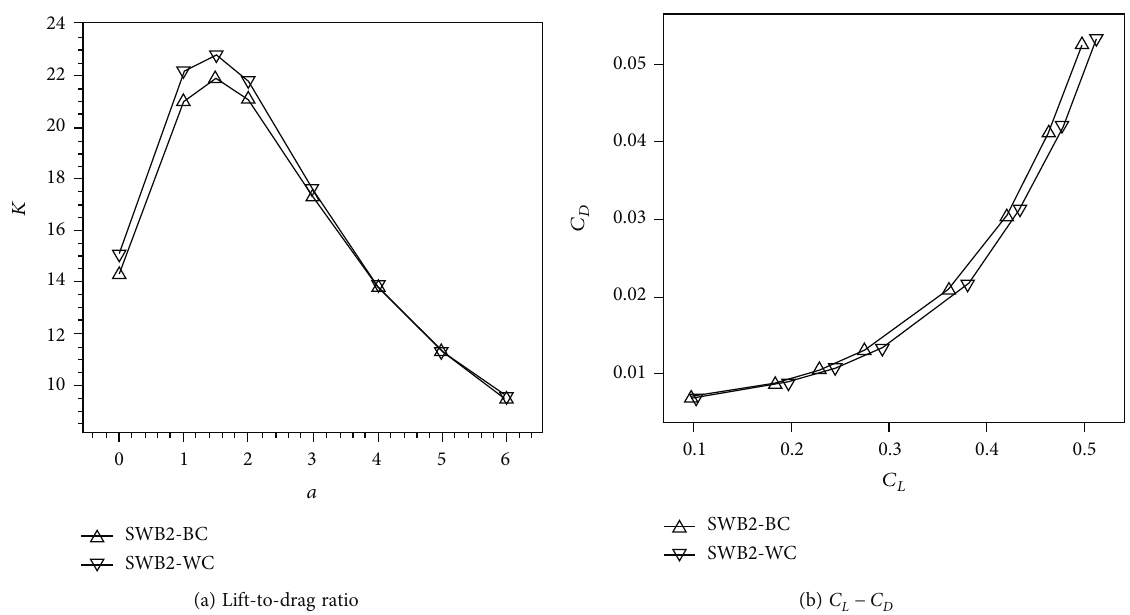
Figure 19: Cruise speed aerodynamic performance compared with SWB-2 BC and